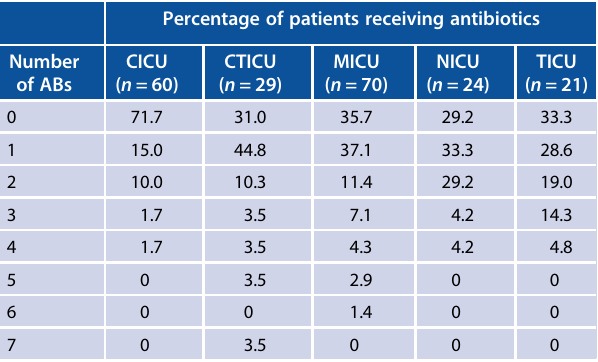
Table 1: Number of antibiotics that patients were prescribed sequentially or concurrently during their stay in the intensive care units